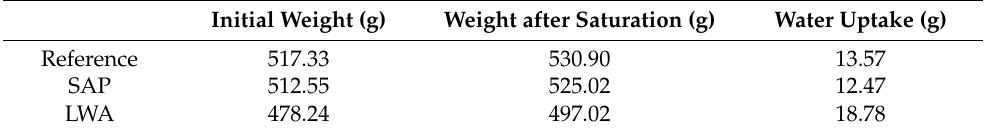
Table 3. Initial weight (g), saturated weight (g) and water uptake (g) of reference, SAP and LWA samples. Initial Weight (g) Weight after Saturation (g) Water Uptake (g)